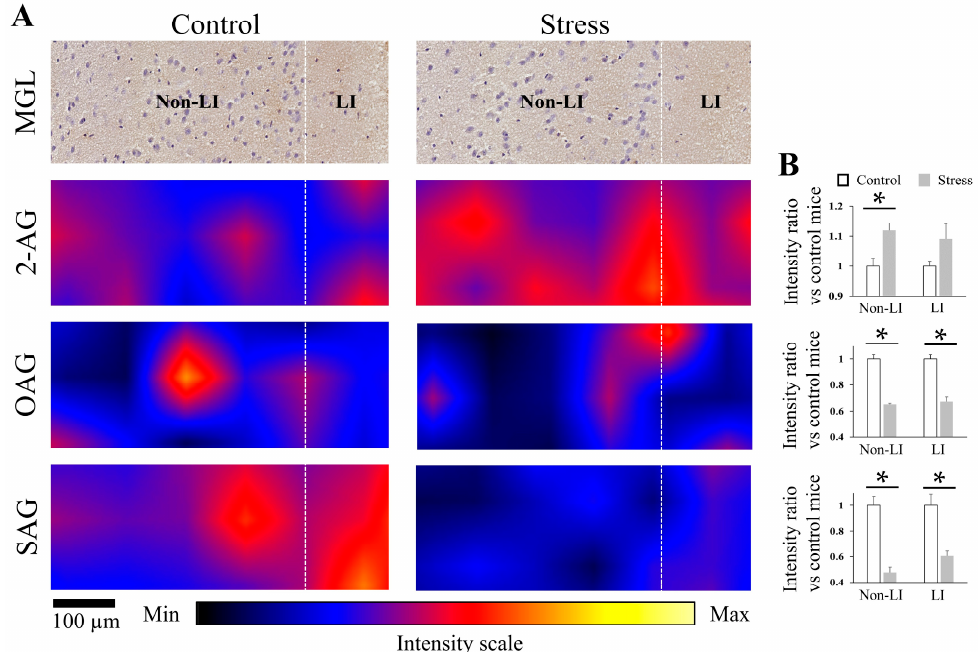
Figure 5. Magnification of 2-AG, OAG, and SAG expression in the LI and non-LI of ACC in control and stressed mice. ( A ) Representative images of ACC section immunostained for MGL and corre- sponding DESI-MSI results of 2-AG, OAG, and SAG in control and stressed mice (scale bar: 100 µ m). ( B ) Fold changes in the average intensity of 2-AG, OAG, and SAG in the LI and non-LI of the ACC sections of stressed mice compared to those of control mice (the number of mice in each group was three). Two-tail t -test was performed. *: p < 0.05. LI: layer I, non-LI: the layers of ACC without layer I.